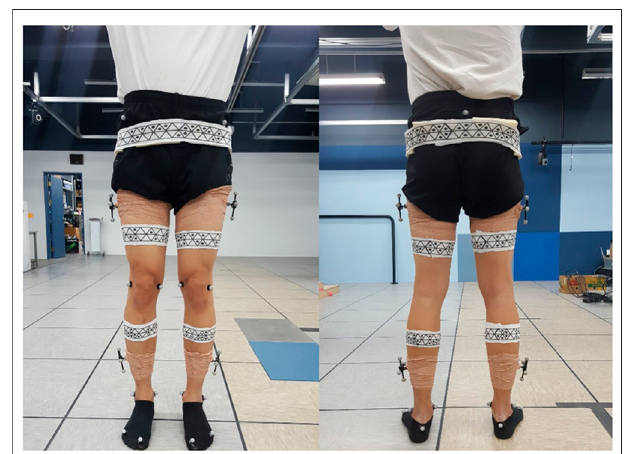
FIGURE 1 | Marker positioning. WSMs and retrore fl ective markers were positioned on the lower limb to evaluate the joint-angle estimation accuracy of the WSM